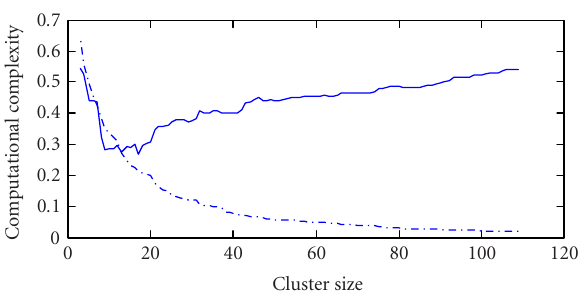
Figure 7: The solid line plots risk and the dashed line plots relative computational complexity versus cluster size of our system. Num- ber of speakers = 110.